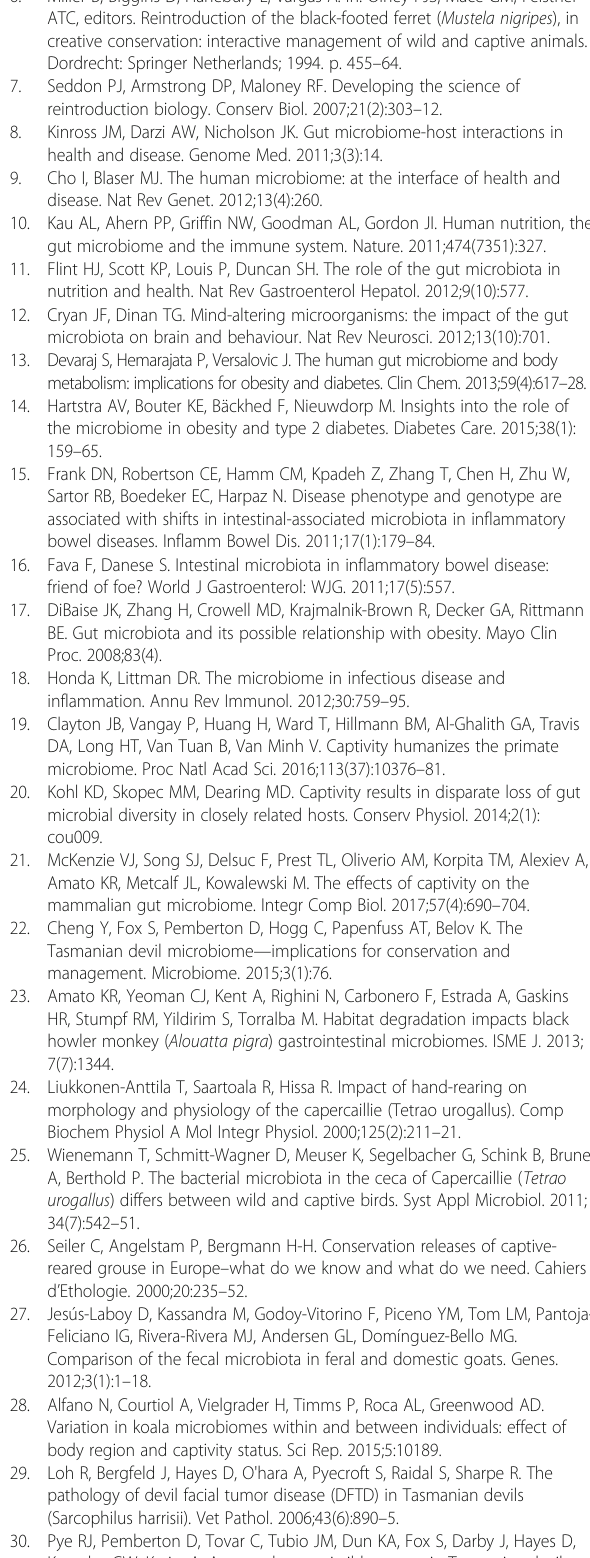
Additional file 6: Table S6. ANCOM analysis of differential abundance for the wild-to-wild translocation. (XLSX 9 kb) Abbreviations DFTD: Devil facial tumour disease; FRE: Free-range enclosures; STDP: Save the Tasmanian Devil